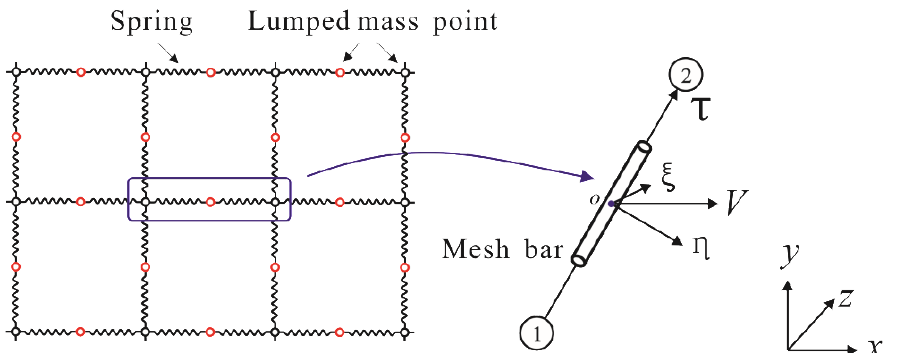
Figure 2. Schematic diagram of the trash-blocking net model.